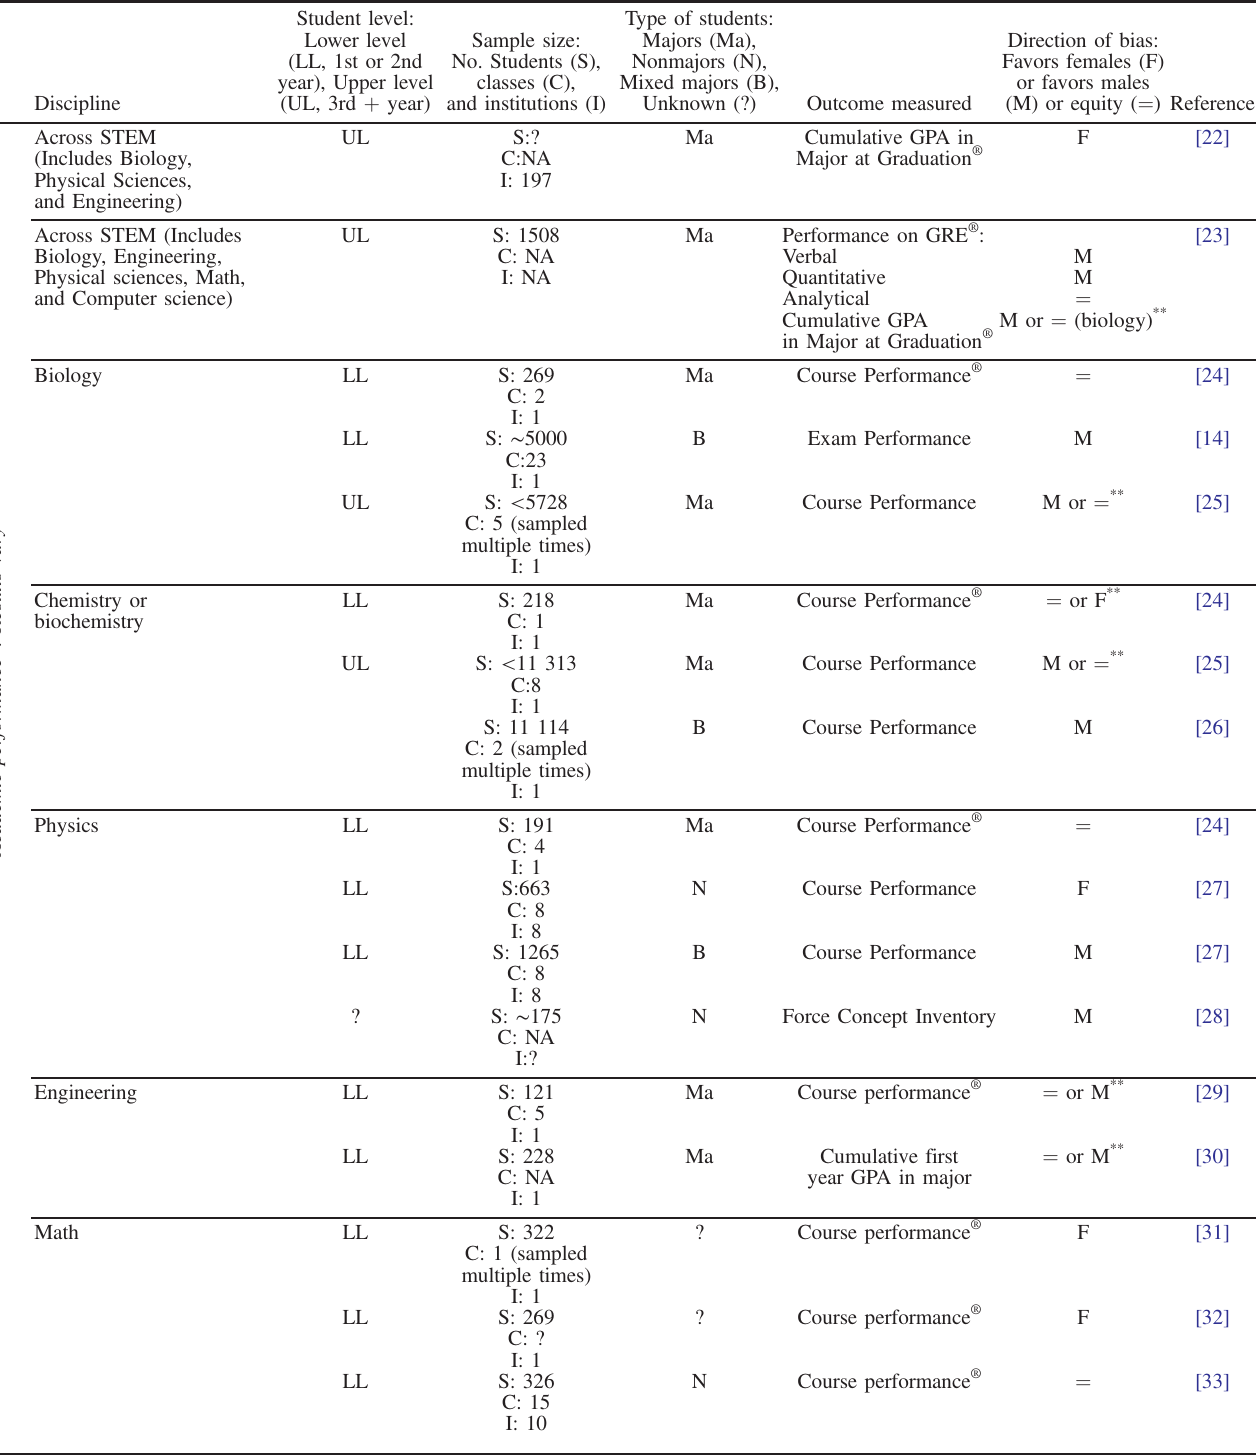
TABLE I. A sample of papers reporting on academic performance and classroom engagement of males and females in two or more STEM classes or with STEM